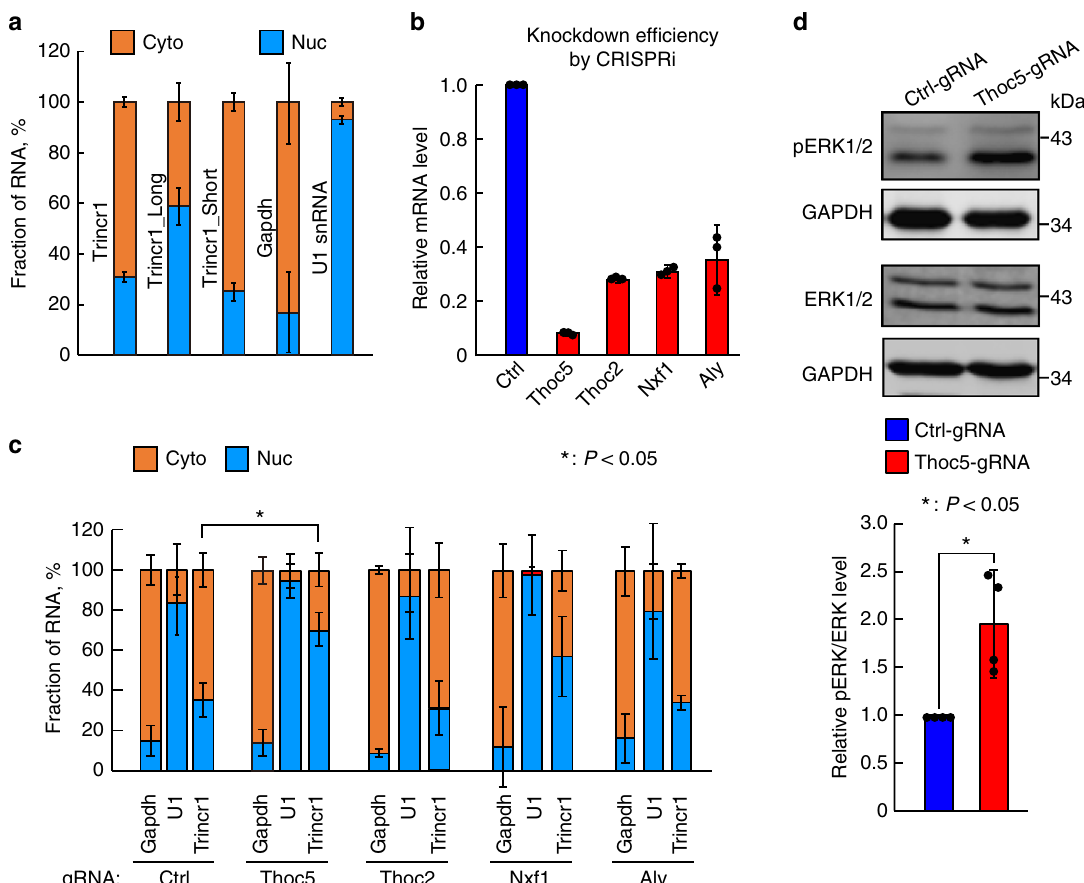
Fig. 4 Thoc5 regulates the export of Trincr1 to cytoplasm. a Fraction of Trincr1 in cytoplasm (Cyto) and nucleus (Nuc). n = 3 independent experiments. Data were normalized by using comparable amounts of nuclear and cytoplasmic lysates from the same cell samples. U1 and Gapdh were used for the quality control of nucleus and cytoplasm fraction, respectively. b RT-qPCR analysis of knockdown ef fi ciency of CRISPRi constructs targeting various components of transcription-export complex. The β -actin gene was used as a control. Data were normalized to ESCs treated with control gRNAs. n = 3 biological replicates. c Fraction of Trincr1 in cytoplasm and nucleus in CRISPRi ESCs. n = 3 independent experiments. Data were normalized by using comparable amounts of nuclear and cytoplasmic lysates from the same cell samples. U1 and Gapdh were used for the quality control of nucleus and cytoplasm fraction, respectively. d Western blotting analysis of phosphorylated ERK in control and Thoc5 CRISPRi ESCs in 2i + LIF. For quanti fi cation of pERK/ERK, data were normalized to GAPDH and then to control gRNA treated ESCs cultured in 2i + LIF. n = 4 independent experiments. Shown are mean ± SD. For c , P values were determined by unpaired two-way ANOVA with two-sided Dunnett ’ s test. For d , P values were determined by paired